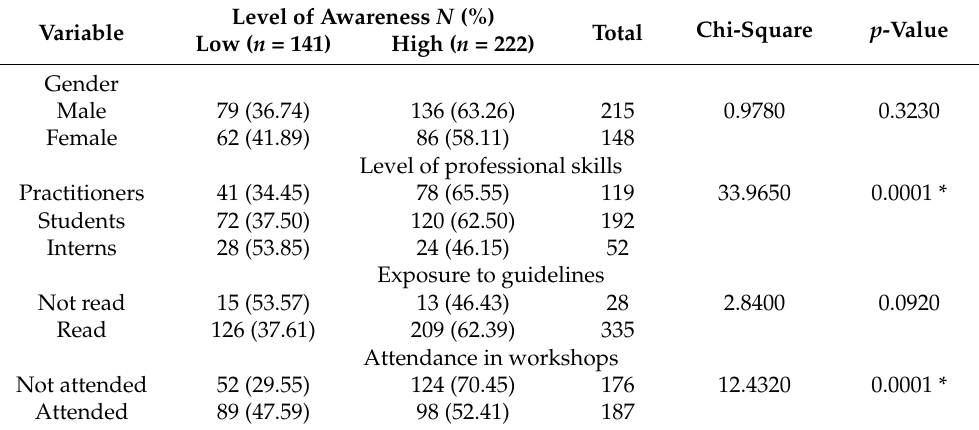
Table 1. Association between levels of awareness with gender, level of professional skills, exposure of guidelines and workshops.